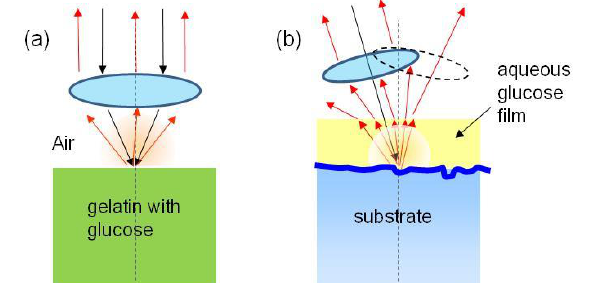
Figure 11. Experimental configurations to measure glucose. (a) glucose was dissolved in the gelatin with a smooth surface. (b) glucose was dissolved in a thin water film or in the substrate with a random surface. For strong diffuse scattering, the optical measurement configuration was not fixed, but varied to study different components of scattered